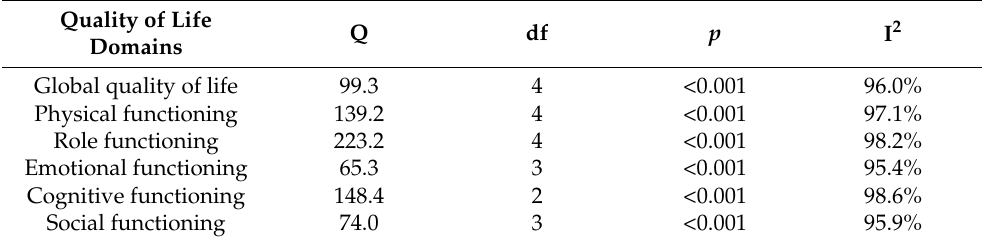
Table 3. Study heterogeneity results for the analyzed QoL domains.